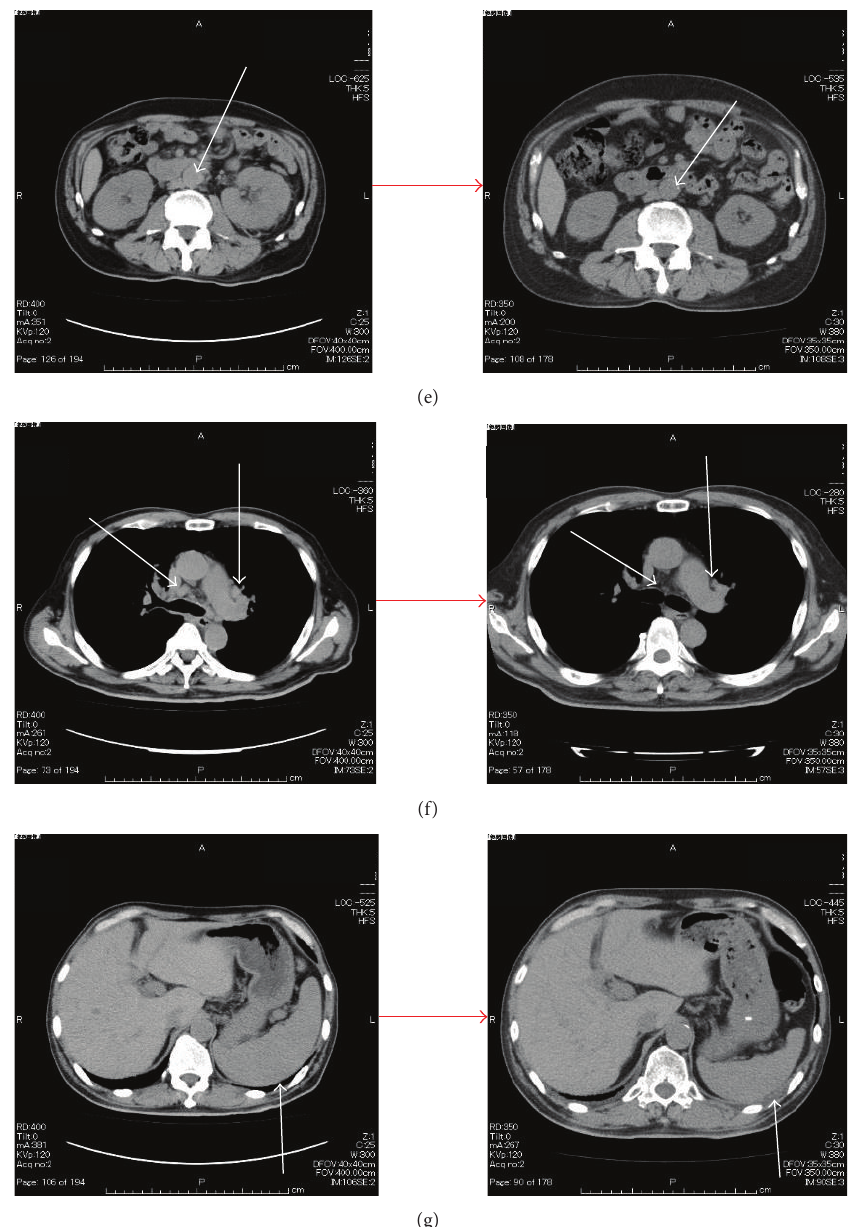
Figure 6: Computed tomography. It showed the improvement of renal enlargement ((a), white arrows), swelling of bilateral salivary glands ((b), white arrows), enlargement of the pancreas ((c), white arrows), centrilobular shadows ((d), white arrows), soft tissue shadows around the aorta ((e), white arrows), mediastinal and pulmonary lymph nodes ((f), white arrows), and splenomegaly ((g), white